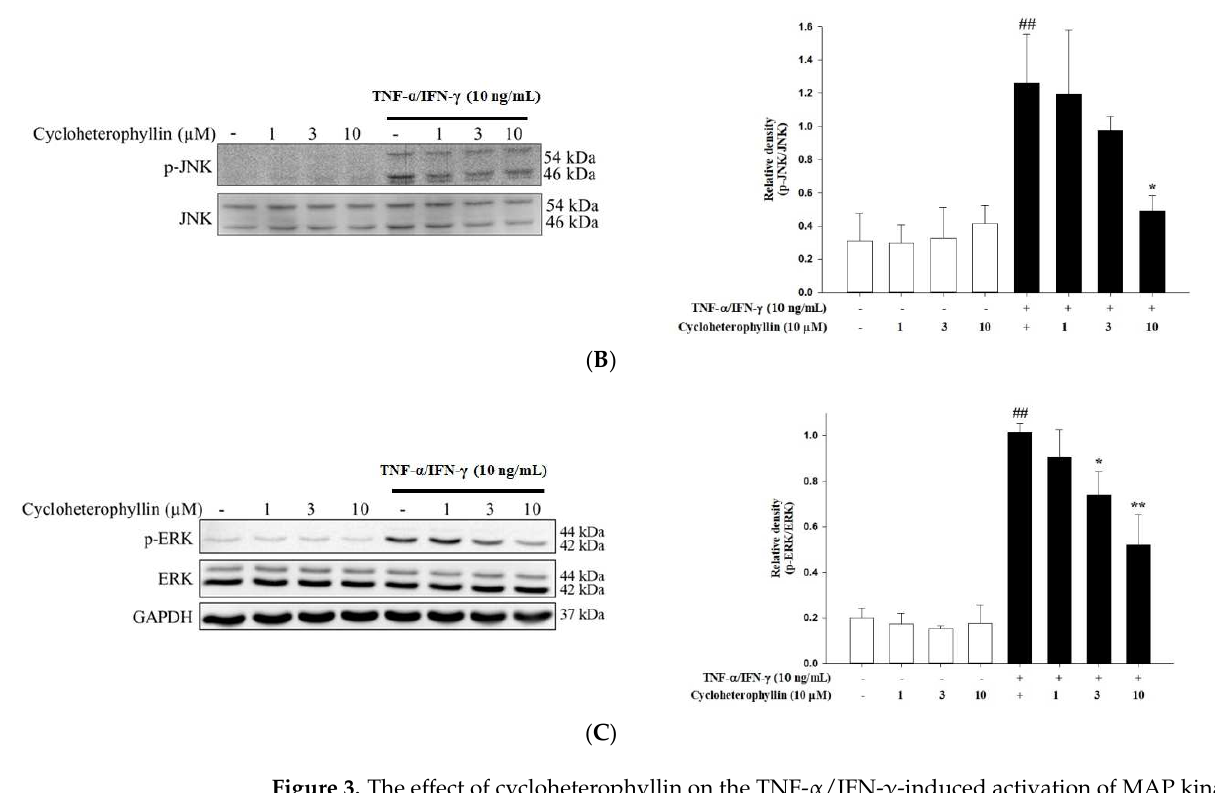
Figure 3. The effect of cycloheterophyllin on the TNF-α/IFN-γ-induced activation of MAP kinases in HaCaT cells. Cycloheterophyllin reduces TNF-α/IFN-γ-induced activation of p38 ( A ), JNK ( B ), and ERK ( C ) in human keratinocyte (HaCaT) cells. HaCaT cells were pretreated with various concentrations of cycloheterophyllin (1, 3, and 10 µ M) for 1 h, and then cells were treated with TNF- α /IFN- γ (10 ng/mL) for 30 min. Quantitative analysis of Western blots was performed. Values represent mean ± SEM from three independent experiments. ## p < 0.01 compared to untreated conditions; * p < 0.05 and ** p < 0.01 compared to TNF- α /IFN- γ treated conditions.